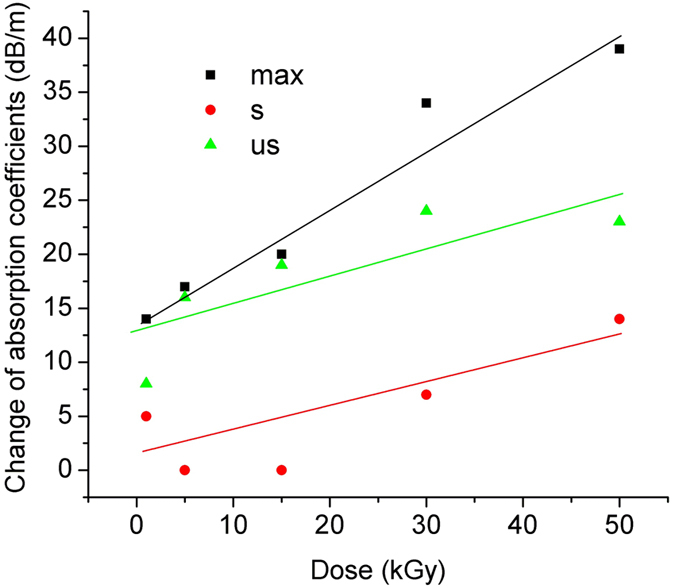
The variation of the pump absorption coefficients: max − Δαmax,
s − Δαs, us − Δαus with the total irradiation dose for the tested samples.